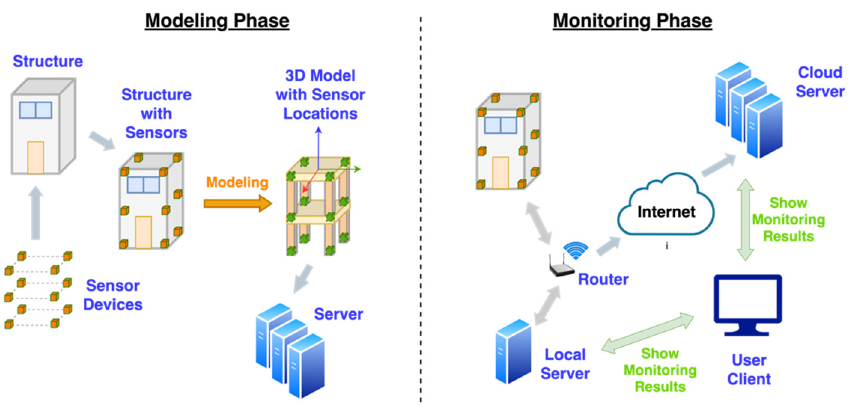
Figure 3. Two different types of the SHM usages.